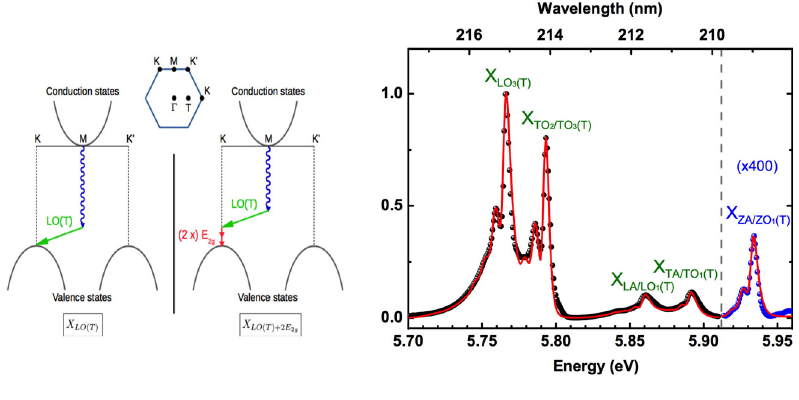
Figure 15: (left) High-energy PL features for BN grown with natural boron Nat B (green), 11 B(red) and 10 B(blue) monoisotopically pu- ri fi ed boron. Note the redshift with decreasing of the average boron mass, which evidences modi fi cations of the phononenergiesovertheseriesofsamples. Right: plot of temperature-induced modi fi - cation of the evolution of the PL line width over the series of samples in correlation with the modi fi cation of the energy of ZO 3 (B 1g ) interlayer silent breathing mode at ( fi tted values are scaling from 50 ± 10 meV, to 70 ± 10, and then115 ± 10 meV in 11 BN,